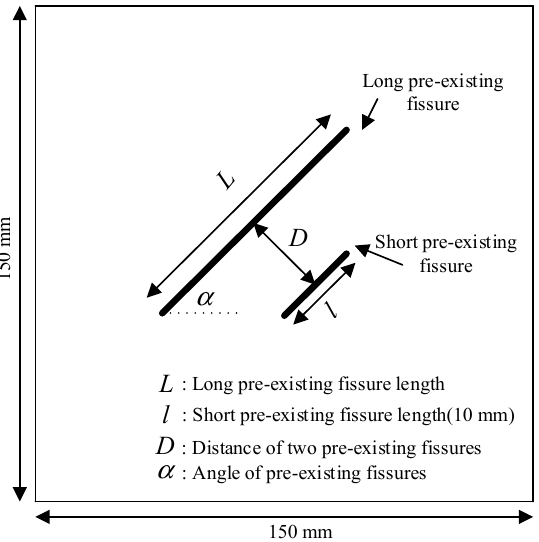
Figure 1. The geometry of the specimen with two unequal parallel prefabricated fissures. Table 1. Geometric parameters of two unequal parallel preexisting fissures.